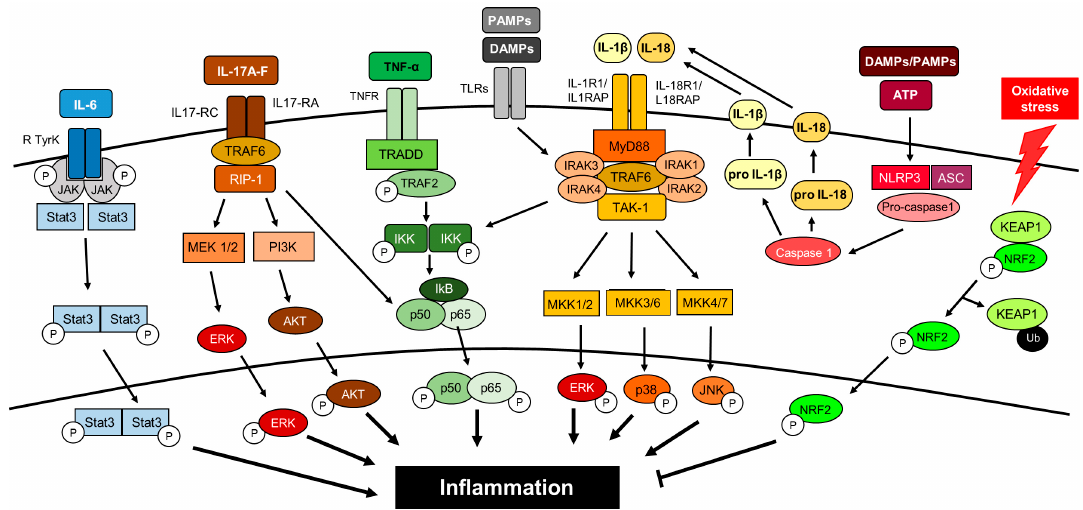
Figure 2. Cytokines and intracellular signaling pathways activating inflammation in DN. This is a simplified view since there are tremendous connections between the different pathways, indicating the complexity of the inflammatory response.